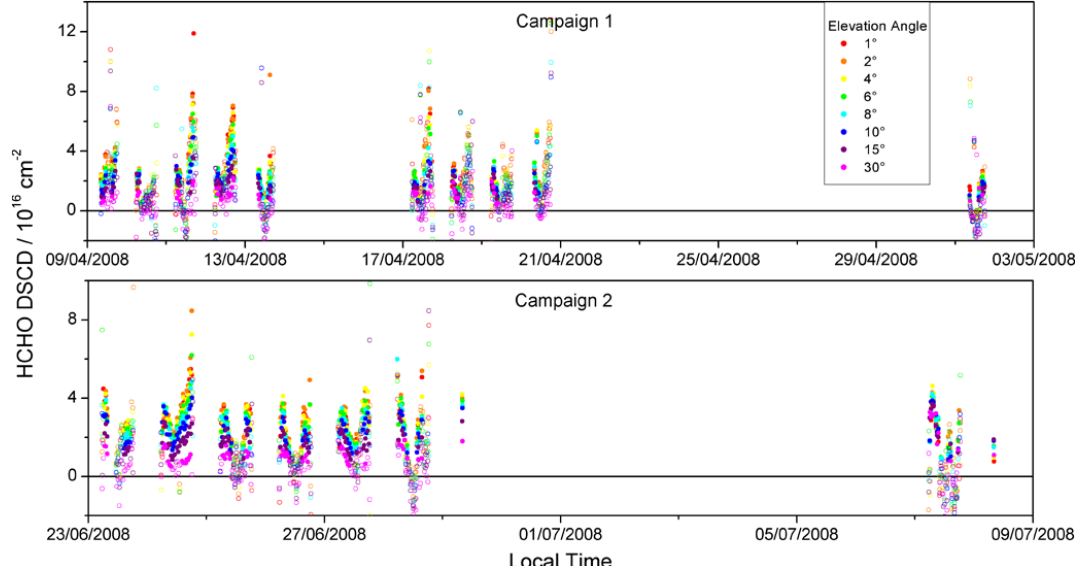
Fig. 6. Time series for formaldehyde measured using the MAX-DOAS over both campaigns. The solid circles represent data above the detection limit while the open circles represent data which were below the detection limit or when there was significant cloud.